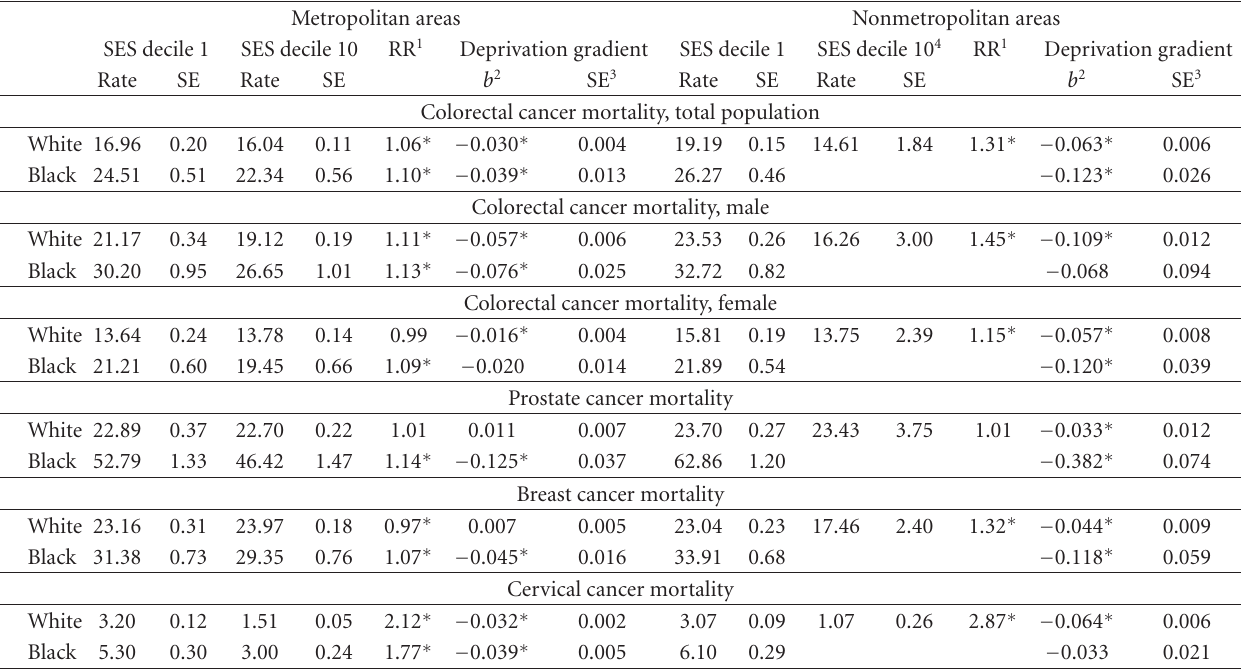
Table 9: Race-specific socioeconomic disparities in colorectal, prostate, breast, and cervical cancer mortality rates per 100,000 population, relative risks (RRs), and gradients in mortality within metropolitan and nonmetropolitan areas of the United States, 2003–2007. Metropolitan areas Nonmetropolitan